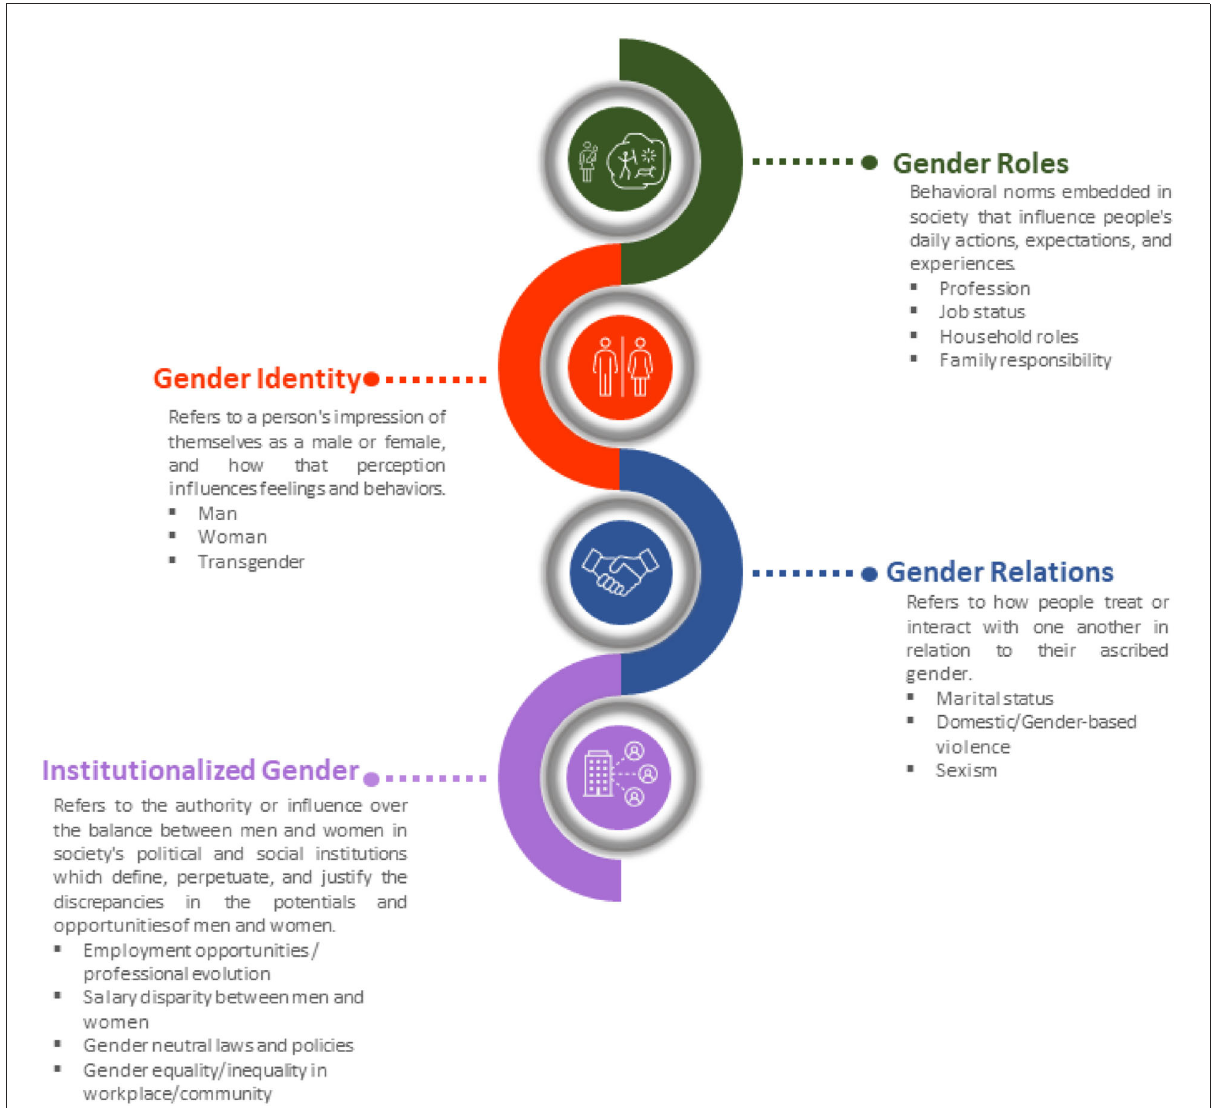
FIGURE2 The four gender domain constructs: gender role, gender identity, gender relations, institutionalized gender refers to a person’s characteristics or qualities in relation to culturally determined